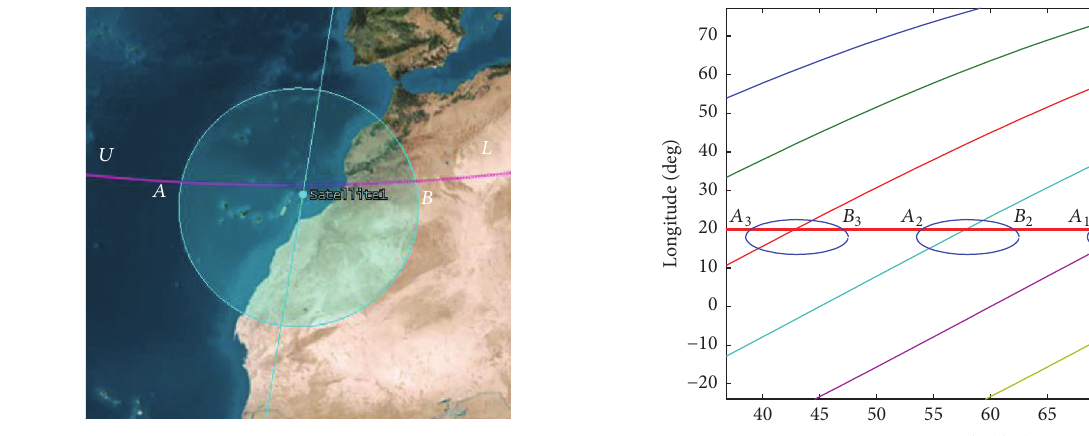
Figure 2: Instantaneous coverage of the satellite to the latitude strip.